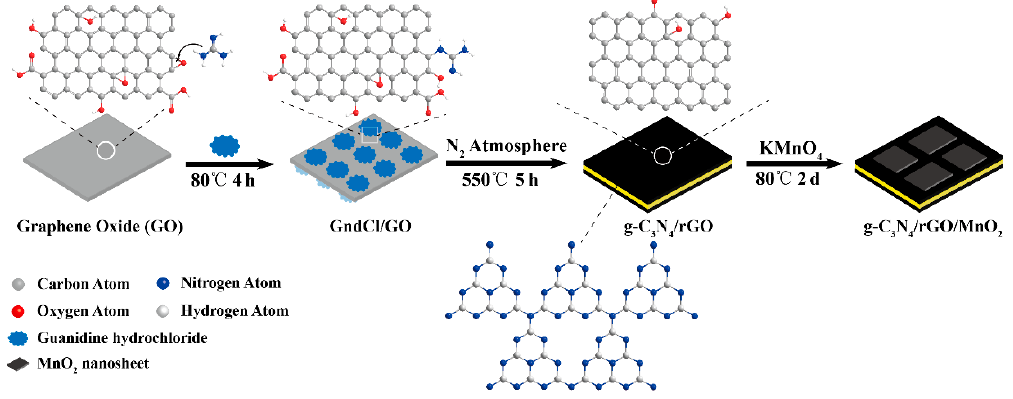
Scheme 1. Illustration of the synthetic method of the g-C 3 N 4 /rGO/MnO 2 ternary nanocomposite.